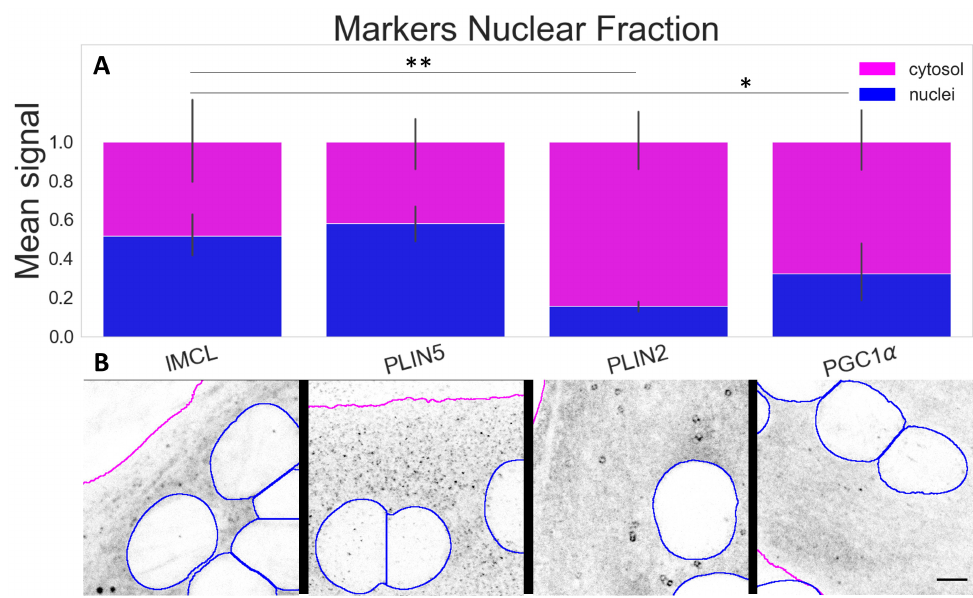
Figure 4. Marker signal comparison between compartments; ( A ) proportion of nuclear signal (blue bars) in relation to cytosolic signal (full bars). Data normalized to the cytosolic reference and measured from the control group (Normal BCAA|Rest). Differences between nuclear fractions of IMCL versus remaining markers * ( p < 0.05) and ** ( p < 0.001). Whiskers signify standard deviation; ( B ) representative images of respective markers. Gray is signal, blue are limits of segmented nuclei, magenta are limits of segmented myotubes. Bar = 5